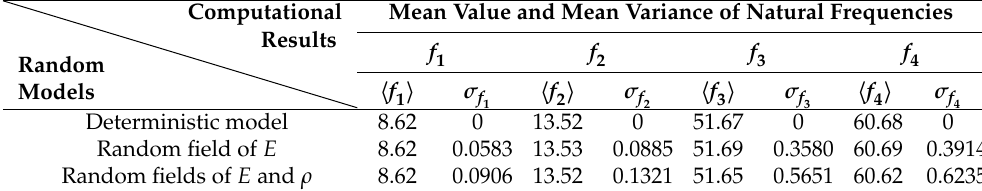
Table 3. The mean values and mean variances of random natural frequencies for different random